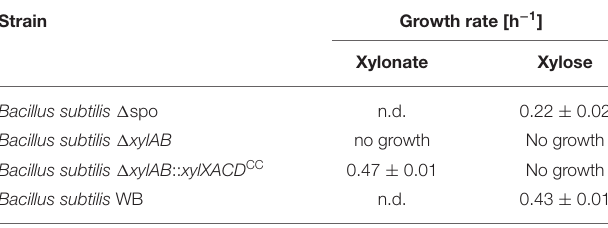
TABLE 2 | Growth of engineered B. subtilis strains on xylose and xylonate.